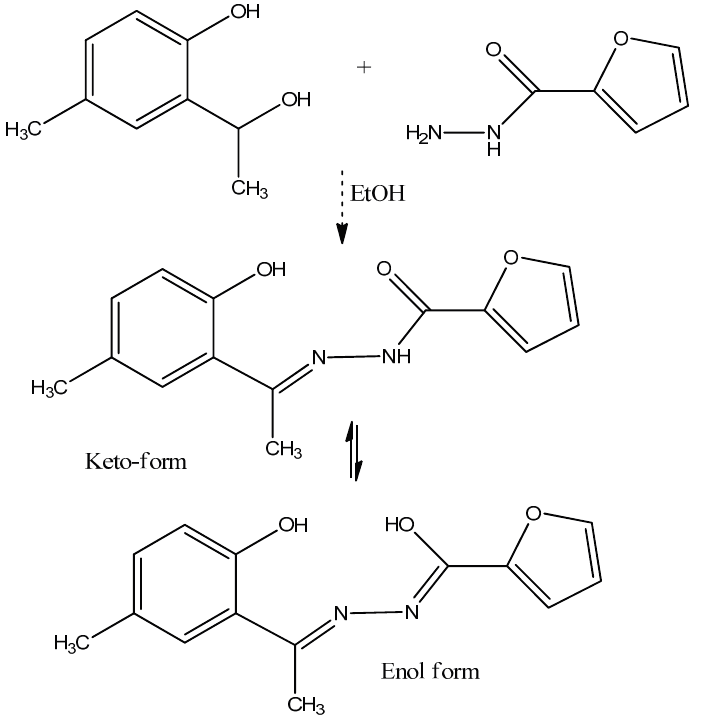
Figure 22. Hydrazone ligand derived from 2-hydroxy-5-methylacetophenone and 2-furoic acid hydrazide.